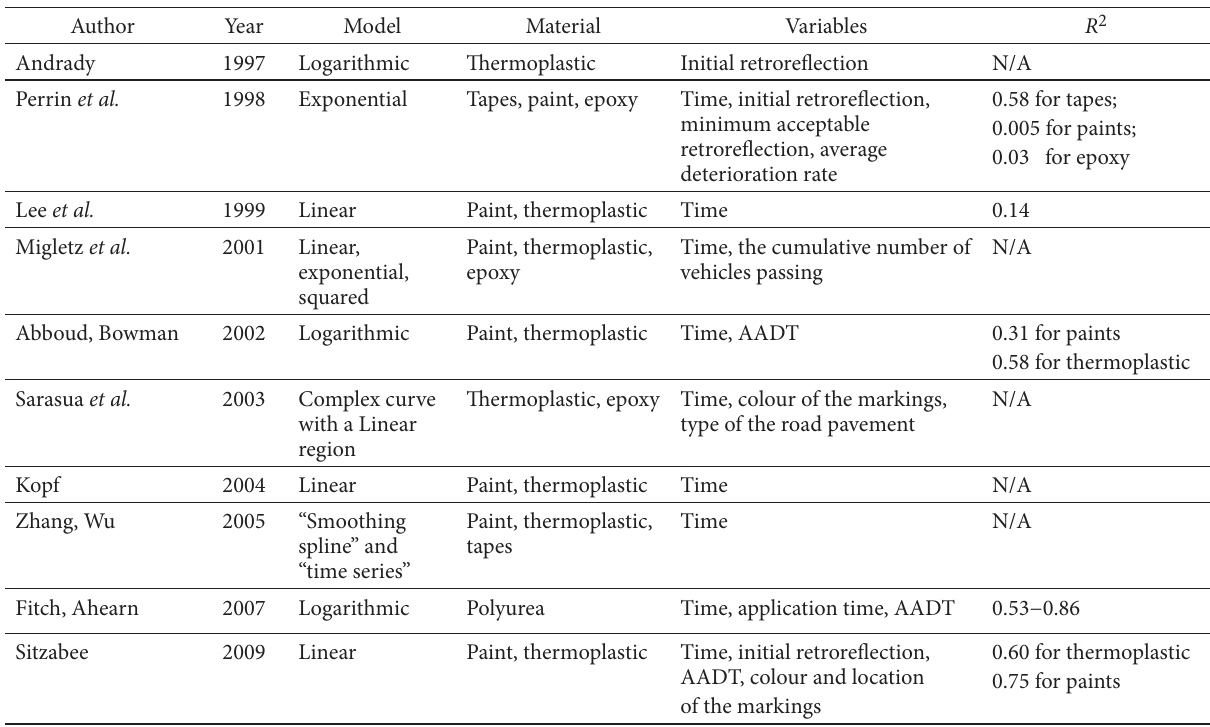
Table 2. Literature review related to modelling the durability of road